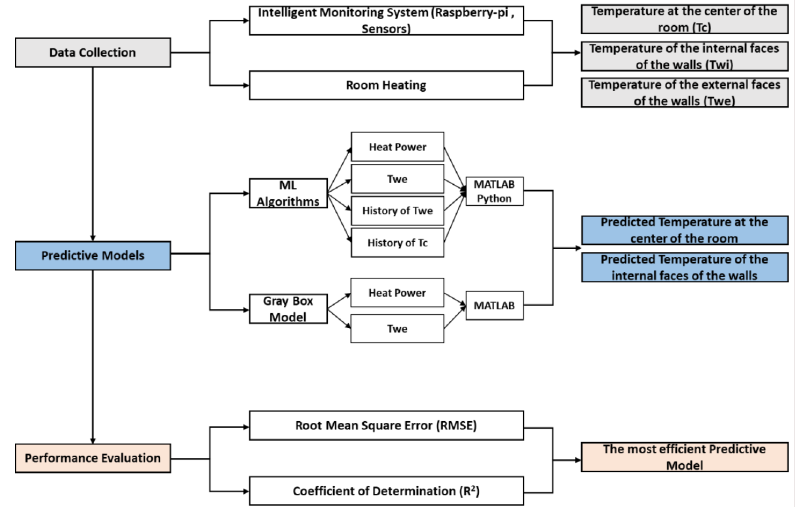
Figure 1. Research